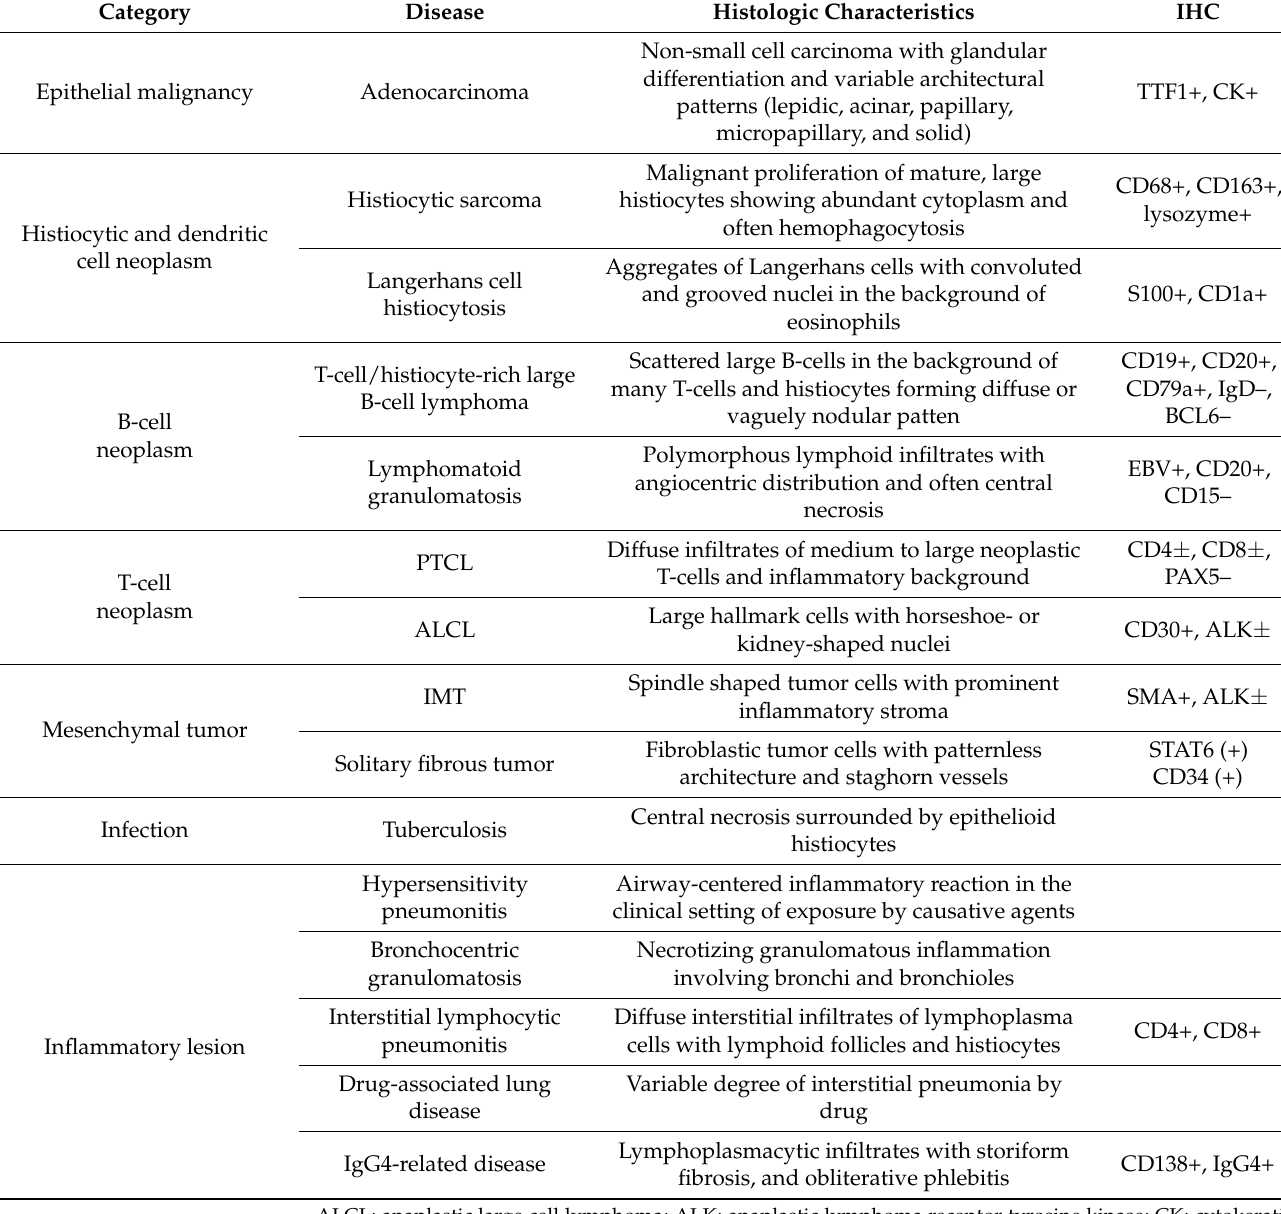
Table 3. Differential diagnosis of